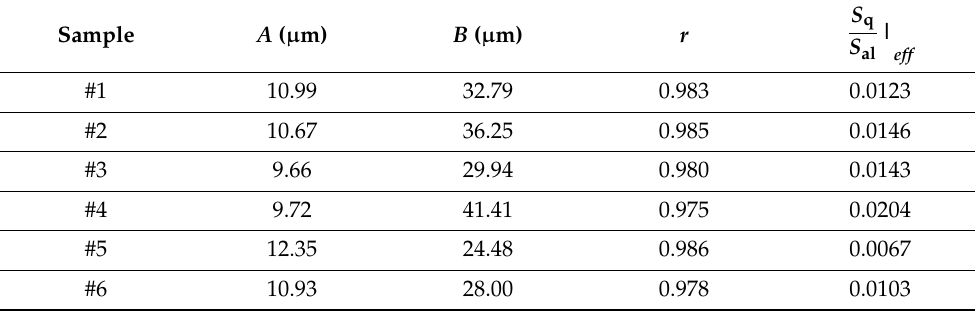
(cid:12) (cid:12) (cid:12) S al ef f